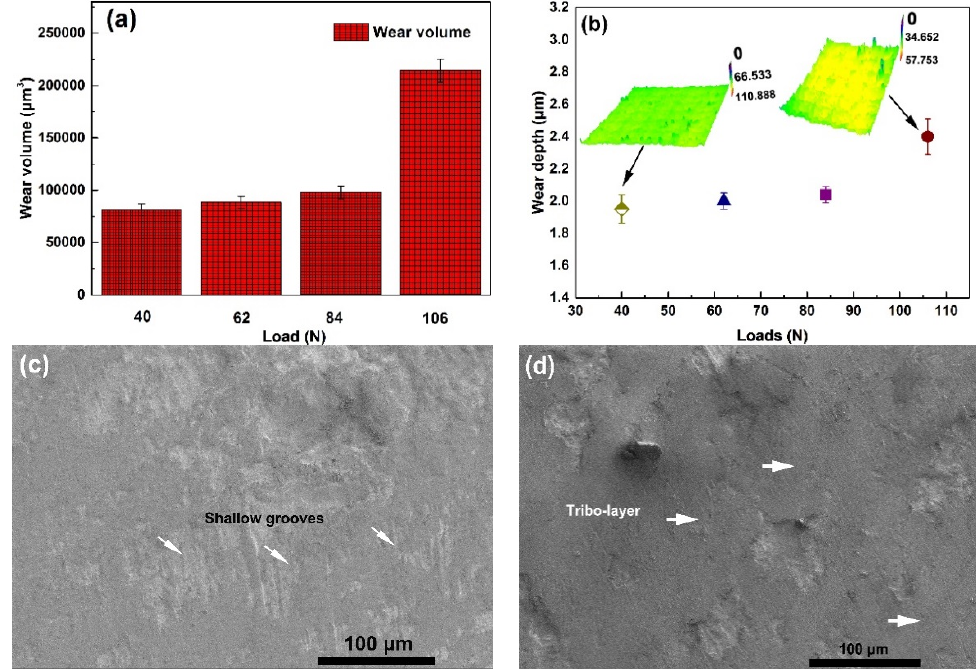
Figure 8. ( a ) Wear volume and ( b ) depth of the fretting wear track of AM-Inconel 625 after fretting wear tests; SEM images of the corresponding wear tracks of AM-processed Inconel 625 after tests at ( c ) 40 and ( d ) 106 N; the insets in b show 3D surface topographies of the wear track at 40 and 106 N load, respectively.